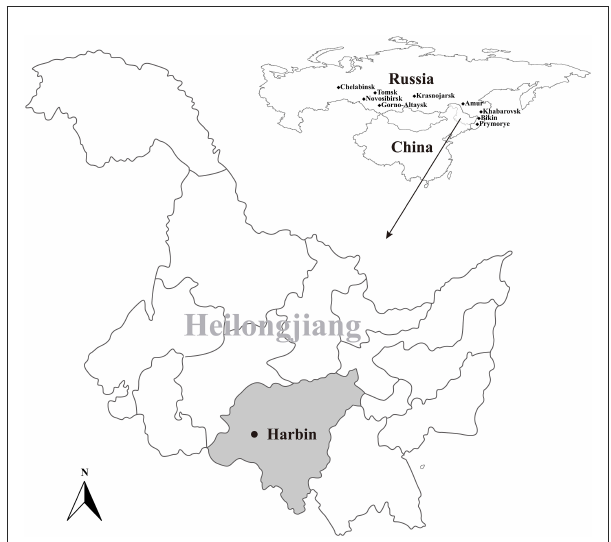
FIGURE1 Geographic maps showing the location of sampling sites from where the rodents were captured in this study. This map was plotted using a combination of Surfer software, Version-4 (Golden Software, Golden, CO, USA), and Adobe illustrator, Version CC2017 (Adobe, San Jose, CA, USA). The black dots indicate the sampling regions in this